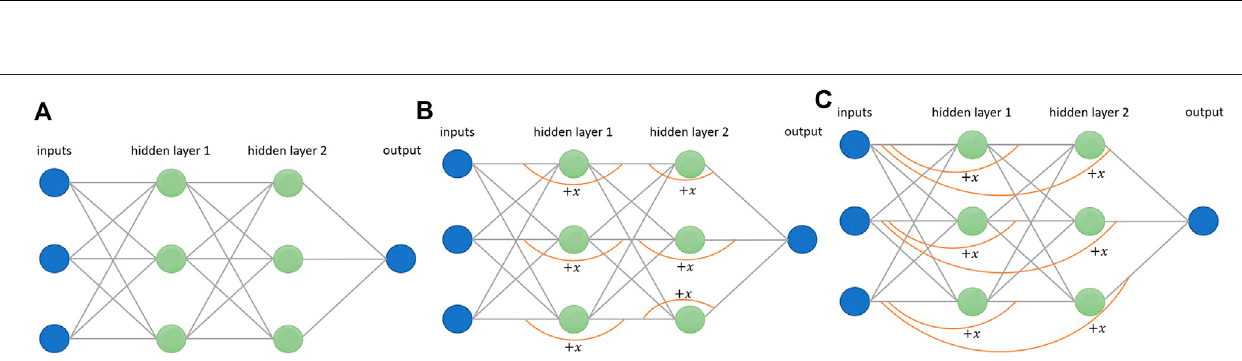
FIGURE 4 | The ESD for all MLPs with two hidden layers and nodes per hidden layer less than or equal to 40 with activation function ReLU, sigmoid, or tanh.